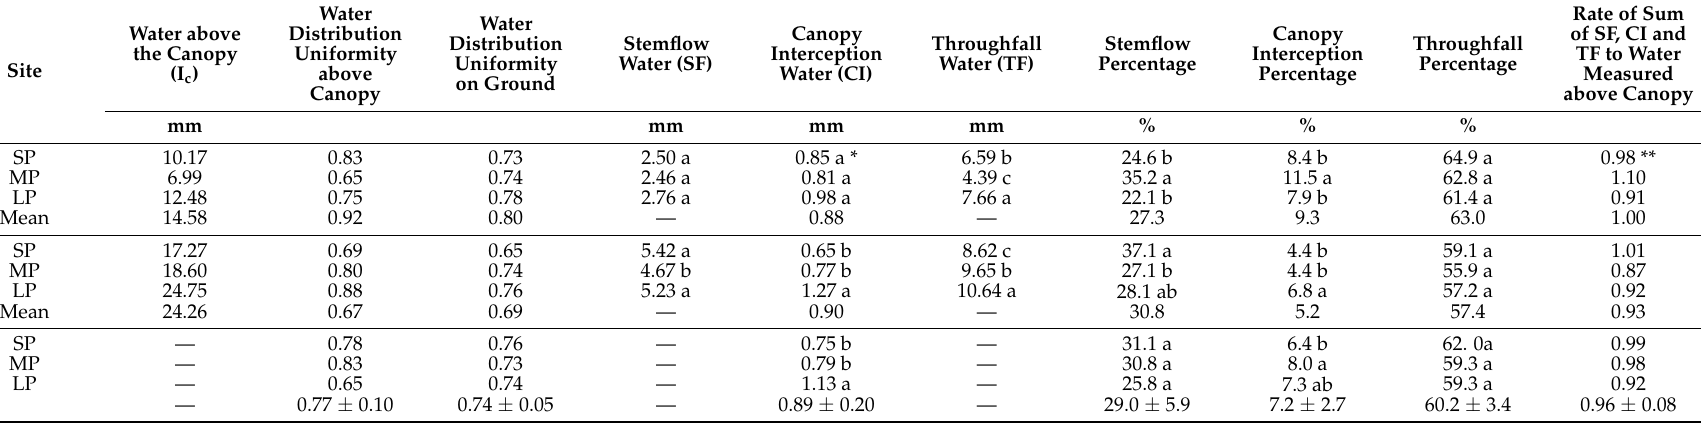
Table 2. The measured water above crop canopy, water distribution uniformity above and below the canopy, stemflow (SF), canopy interception (CI) and throughfall (TF) and their percentages and the rate of the total SF, CI and TF to the water measured above the canopy (I c ).